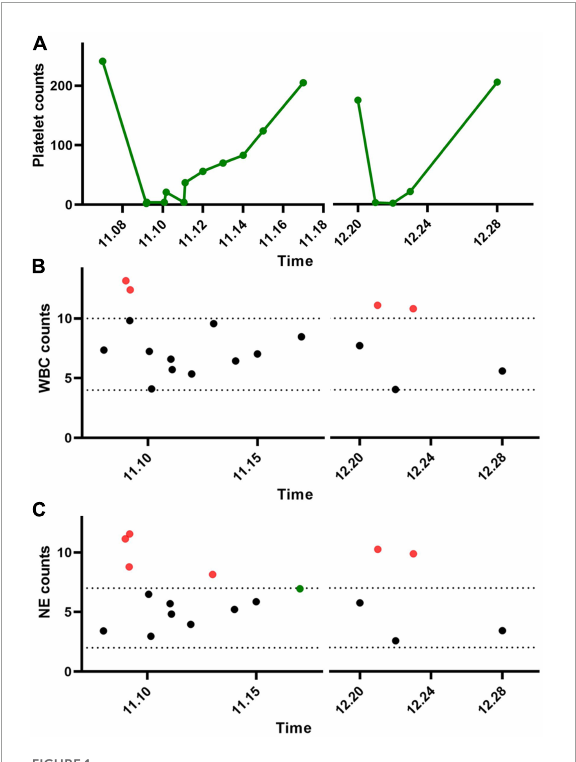
FIGURE1 Changes in platelets and leukocytes after two trastuzumab treatments in the patient. (A) Platelets, (B) white blood cells, and (C)